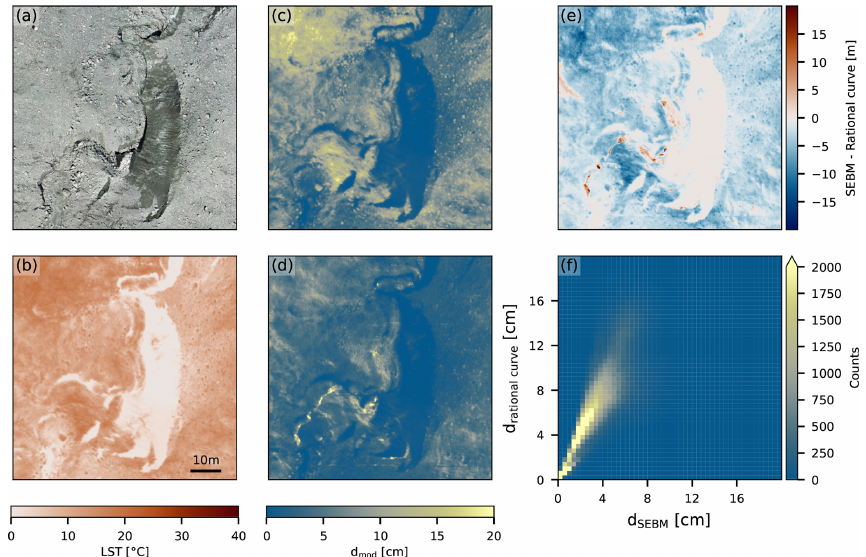
Figure 13. High-resolution subsection of the unpiloted aerial vehicle (UAV) imagery with debris cover, large boulders, and an ice cliff. The panels show (a) the RGB image, (b) the land surface temperature at 15:00 (UTC + 1), (c) debris-thickness prediction using the rational curve approach, and (d) debris-thickness prediction by solving the surface energy balance model. The difference map (e) and 2D histogram (f) show how the model predictions compare